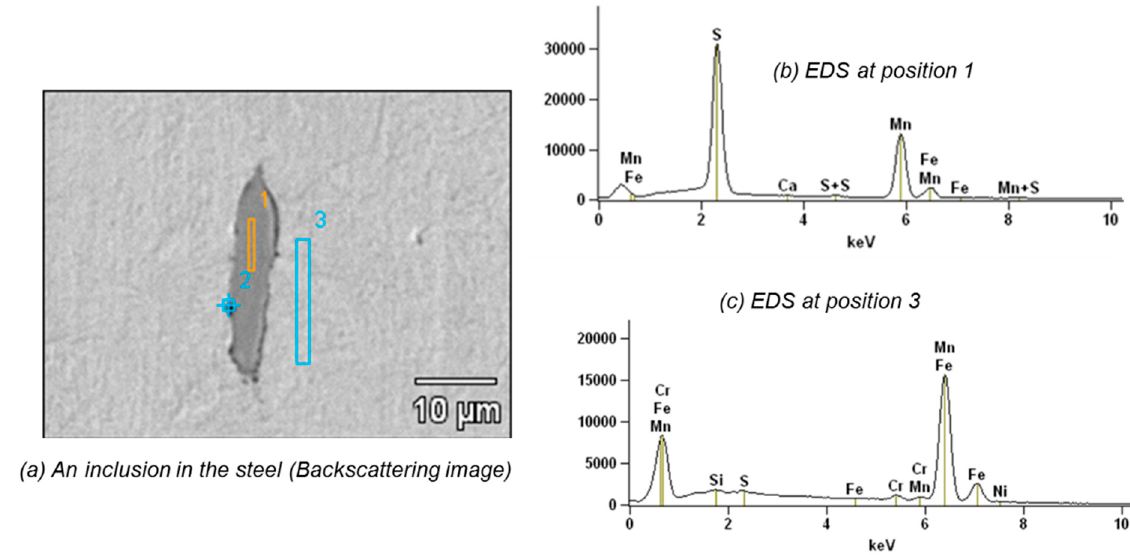
Figure 18. An inclusion (backscattering image ( a ), EDS plots in the position 1 ( b ) and at position 3